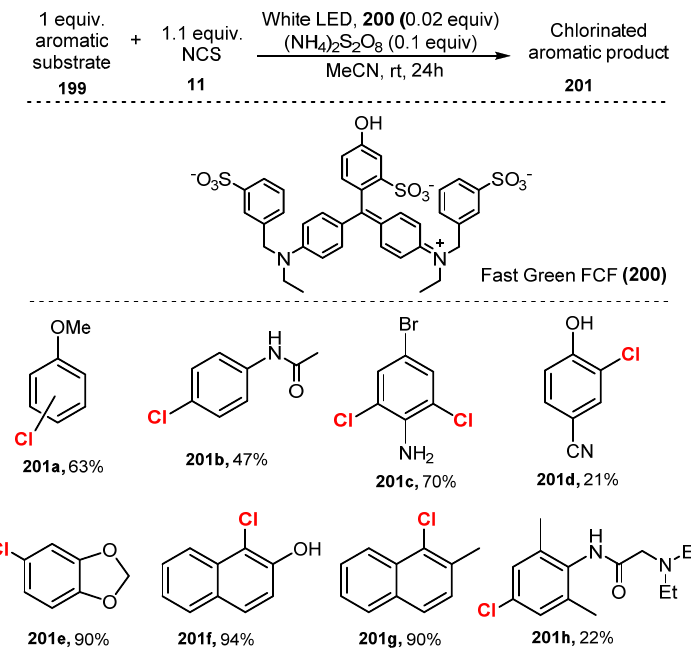
Scheme 53. Visible-light-promoted chlorination of aromatics and heteroaromatics.